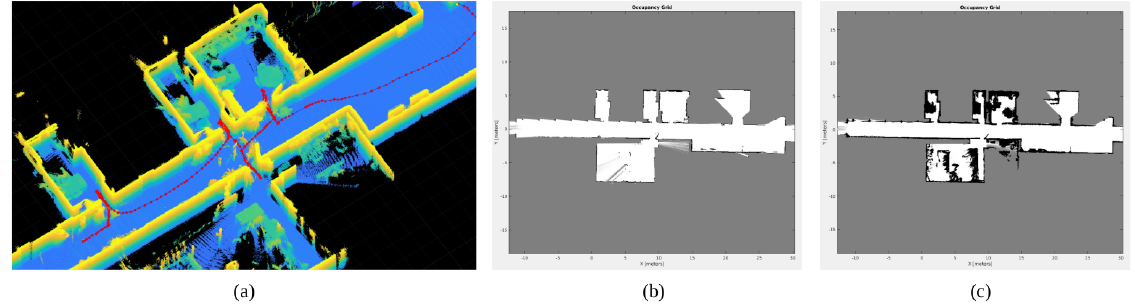
Figure 19. Mapping results: ( a ) global point cloud, where red dots are corrected robot poses, ( b ) layout grid map, and ( c ) navigation grid map.